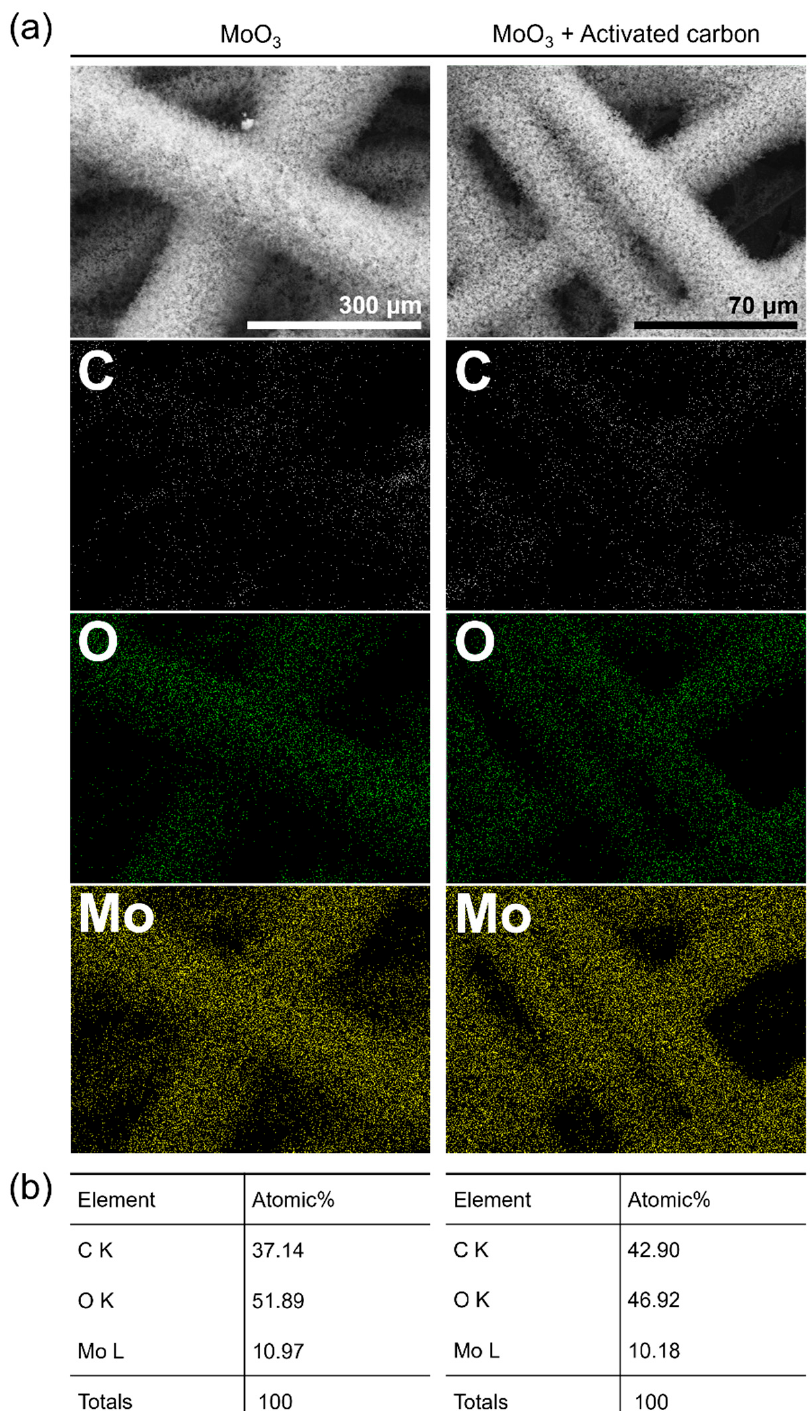
Figure 3. ( a ) EDS elemental maps and ( b ) atomic ratios of C, O, and Mo acquired for the molybdenum oxide nanoparticle aggregates prepared on CFP substrates by the CVT method using two different types of precursors: MoO 3 and 1:1 (mol/mol) mixture of MoO 3 and activated carbon. The XRD analysis was performed for all samples, and the acquired diffraction pat- terns are shown in Figure 4. The peaks corresponding to α -MoO 3 and γ -Mo 4 O 11 are re- vealed for the molybdenum oxide nanoparticle aggregates formed on CFP using ‘M’ ac- cording to the Joint Committee on Powder Diffraction Standards (JCPDS) no. 05-0508 and 05-0338, respectively. For the sample prepared using ‘MC’, the peaks arising from α -MoO 3 weakened, while the main peak arising from γ -Mo 4 O 11 was slightly strengthened com- pared with the sample prepared using ‘M’. However, the peaks arising from molybdenum oxide were hard to observe because of the strong peaks arising from CFP substrate. Hence,